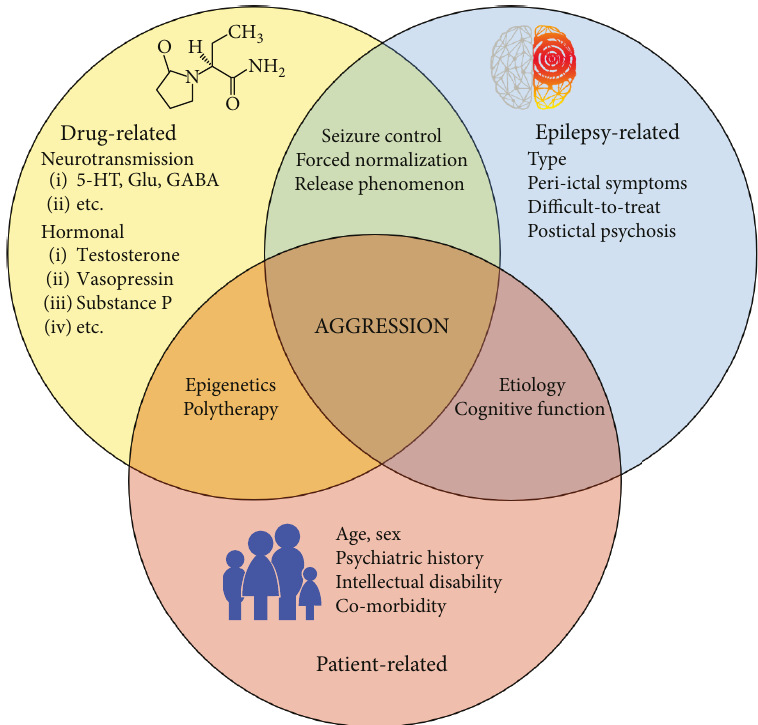
Figure 1: Summary of factors involved in aggressive behavior associated with antiepileptic drug treatment of